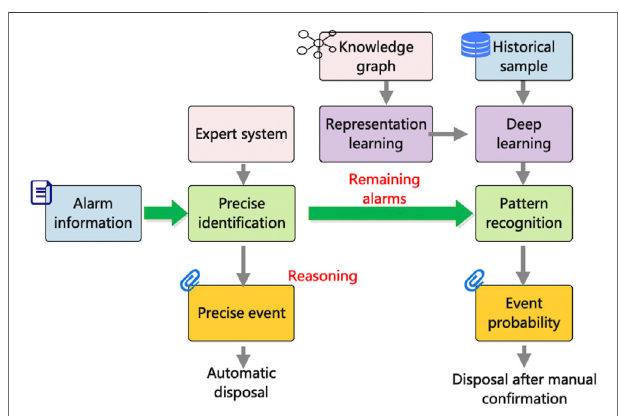
FIGURE 6 | Monitoring event recognition strategy process.